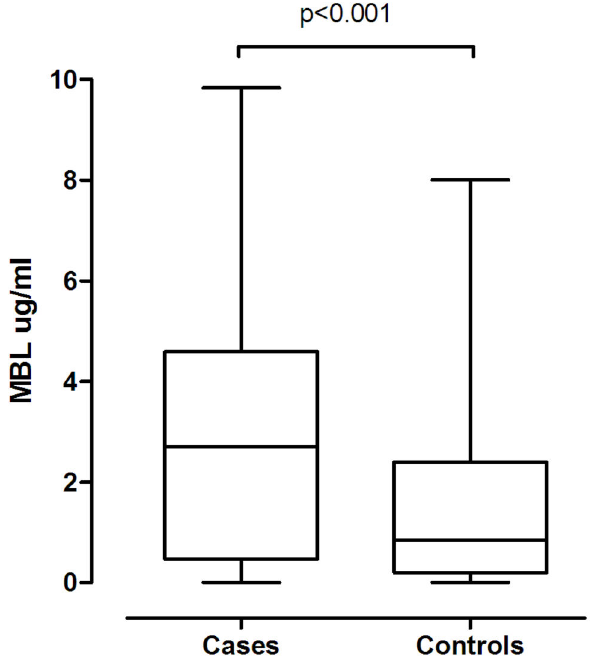
Figure 1. Plasma mannose-binding lectin levels in S. aureus BSI cases and controls. Differences in plasma mannose-binding lectin levels in S. aureus BSI cases and